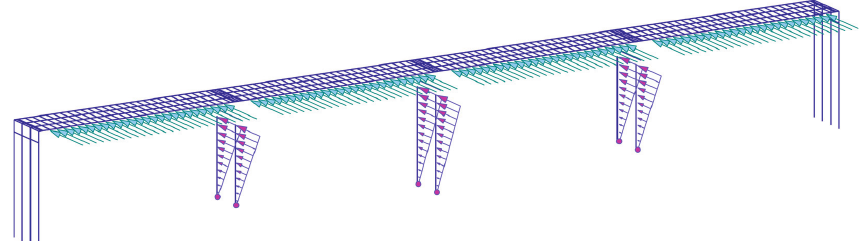
Figure 25: Sketch of loading distribution in pushover